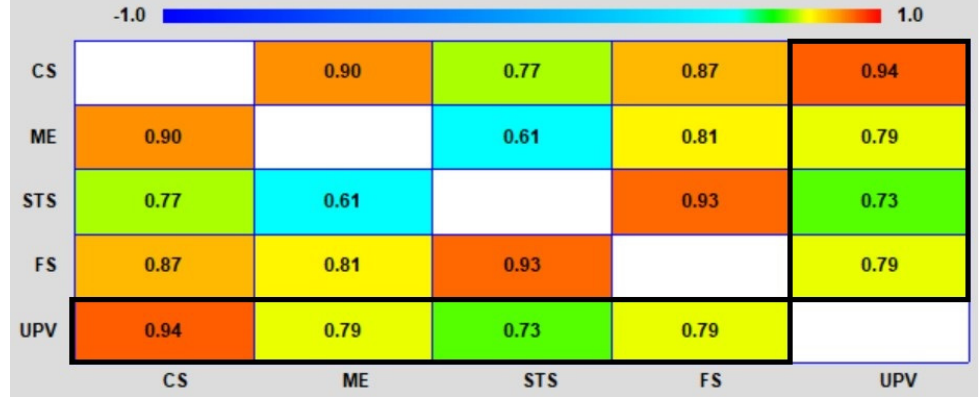
Figure 5. Pearson correlation matrix. Correlations between UPV readings and mechanical properties marked within the thick black border.